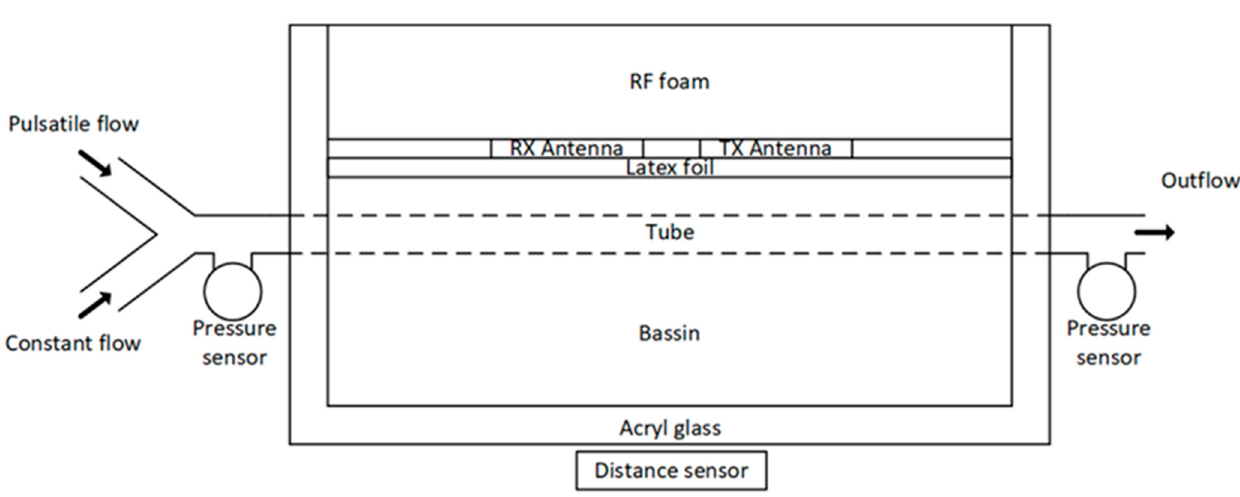
Figure 9. Macroscopic model environment for evaluation of continuous wave radar with pressure and distance reference measurements.